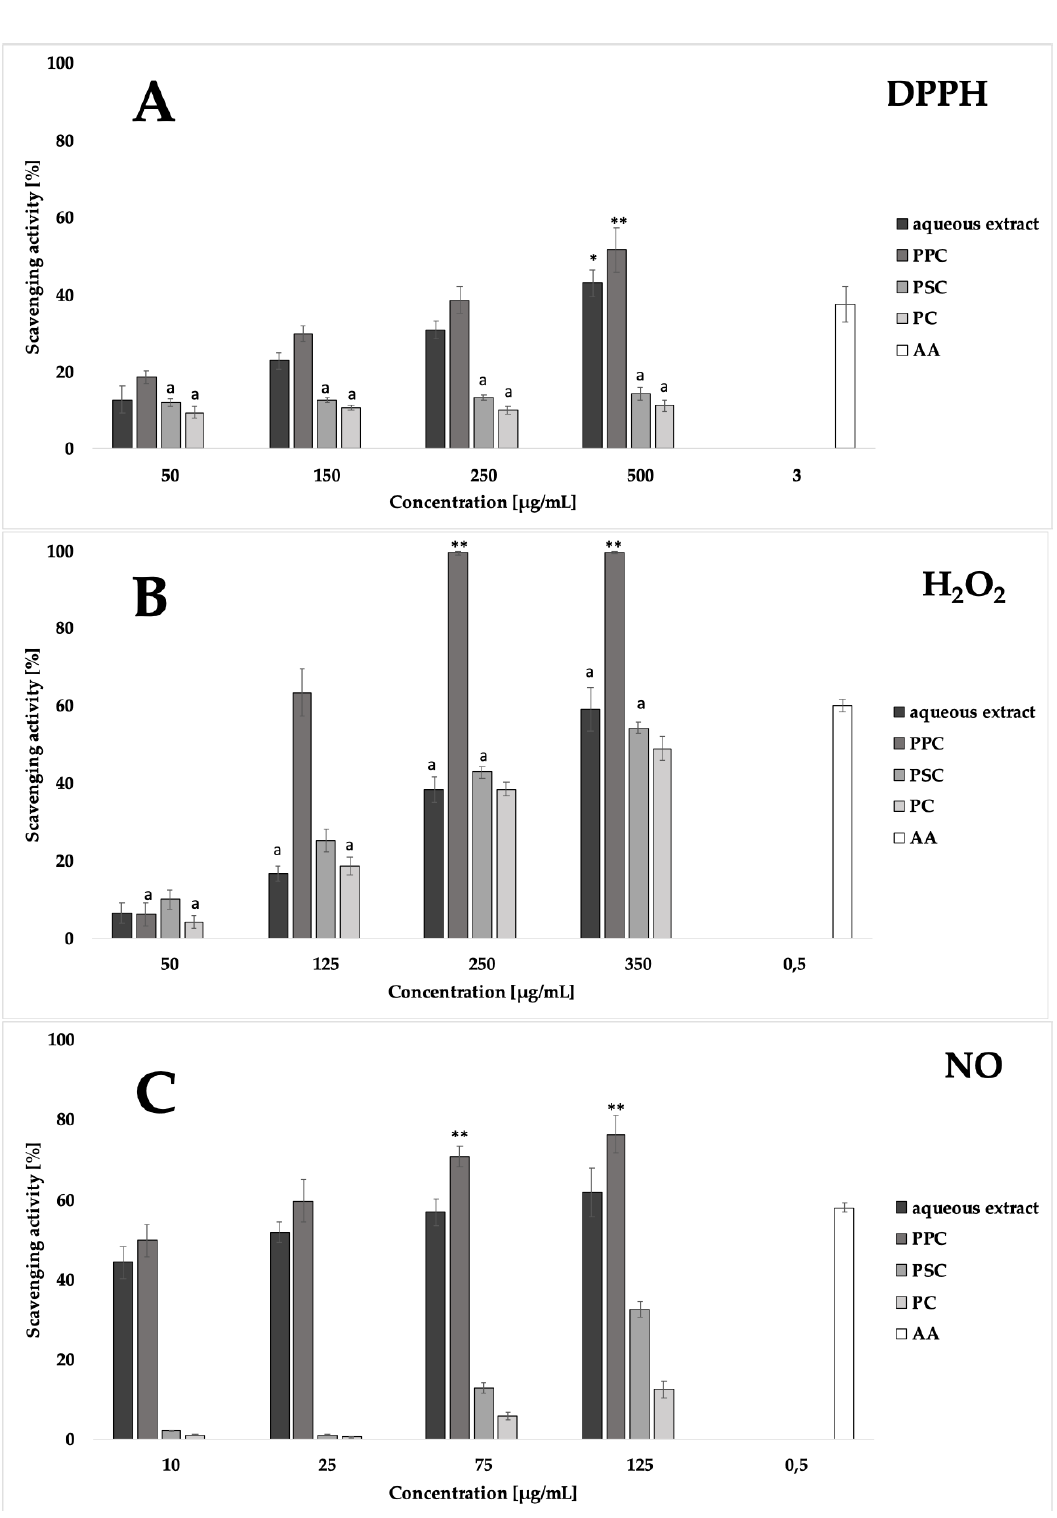
Figure 2. Scavenging activity of raw extract and BAFs against DPPH ( A ), H 2 O 2 ( B ) and NO ( C ) species, AA—ascorbic acid (positive control). *, **—significant stronger activity in comparison to the control at p < 0.05 and p < 0.01, respectively, a—not significant difference between the tested extracts activity at p < 0.05.